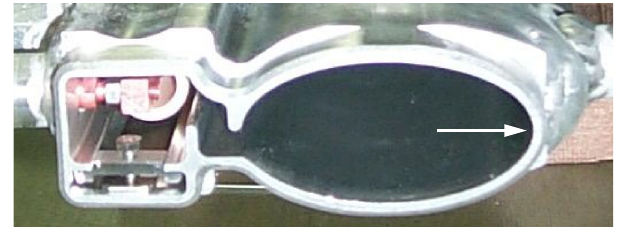
FIG. 1. PETRA III dipole vacuum chamber. The end of the chamber is shown with the ante chamber at the left side. A NEG strip is mounted in the ante chamber. The full width of the elliptical chamber is 80 mm and the full height is 40 mm. The arrow indicates where the primary synchrotron radiation is hitting the chamber wall.